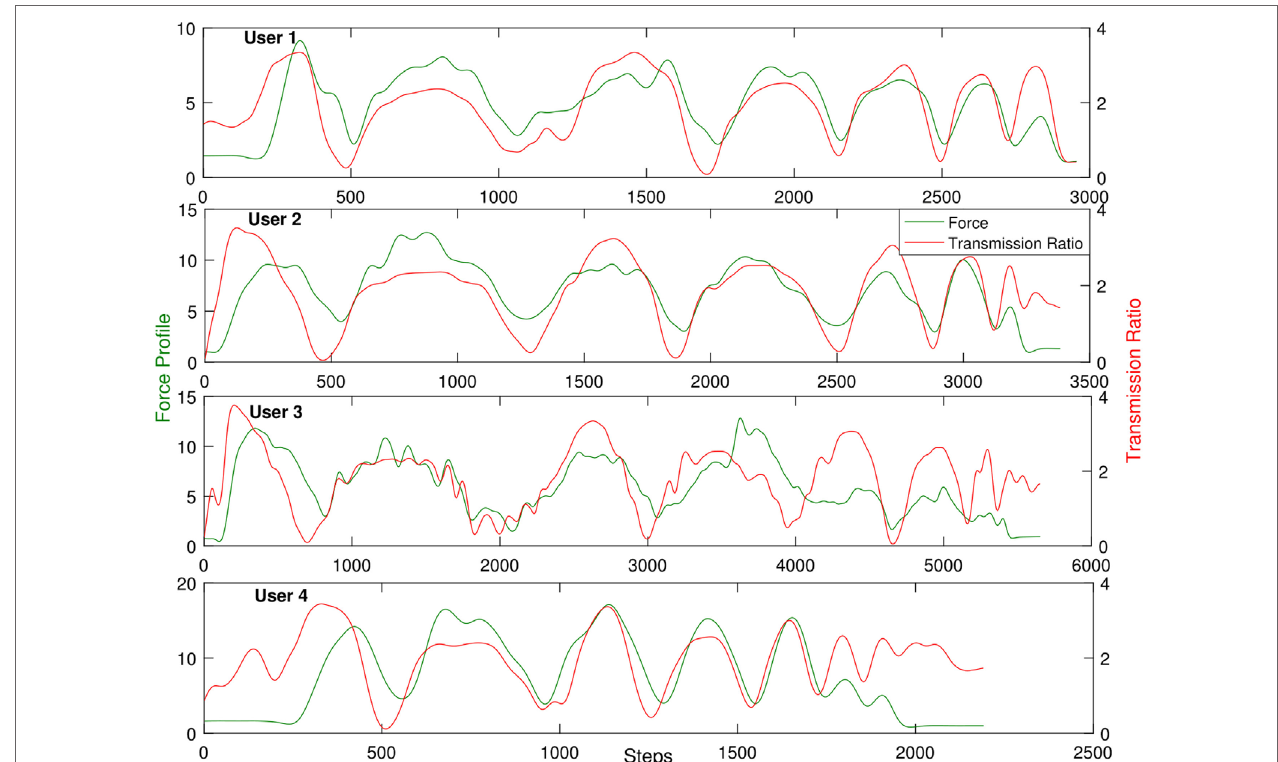
FigUre 10 | Graph showing predicted transmission ratio along the trajectory and its correlation with user’s interaction forces.